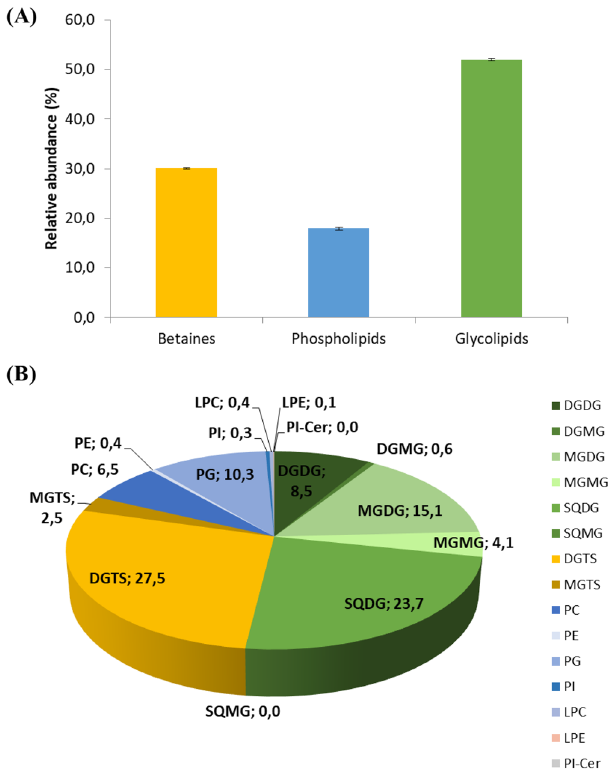
Figure 7. ( A ) Representation of the relative percentage of betaines, phospholipids and glycolipids present in Chlorococcum amblystomatis . Values are represented by an average of five replicates ± standard deviation. ( B ) The relative percentage of each class of lipids.